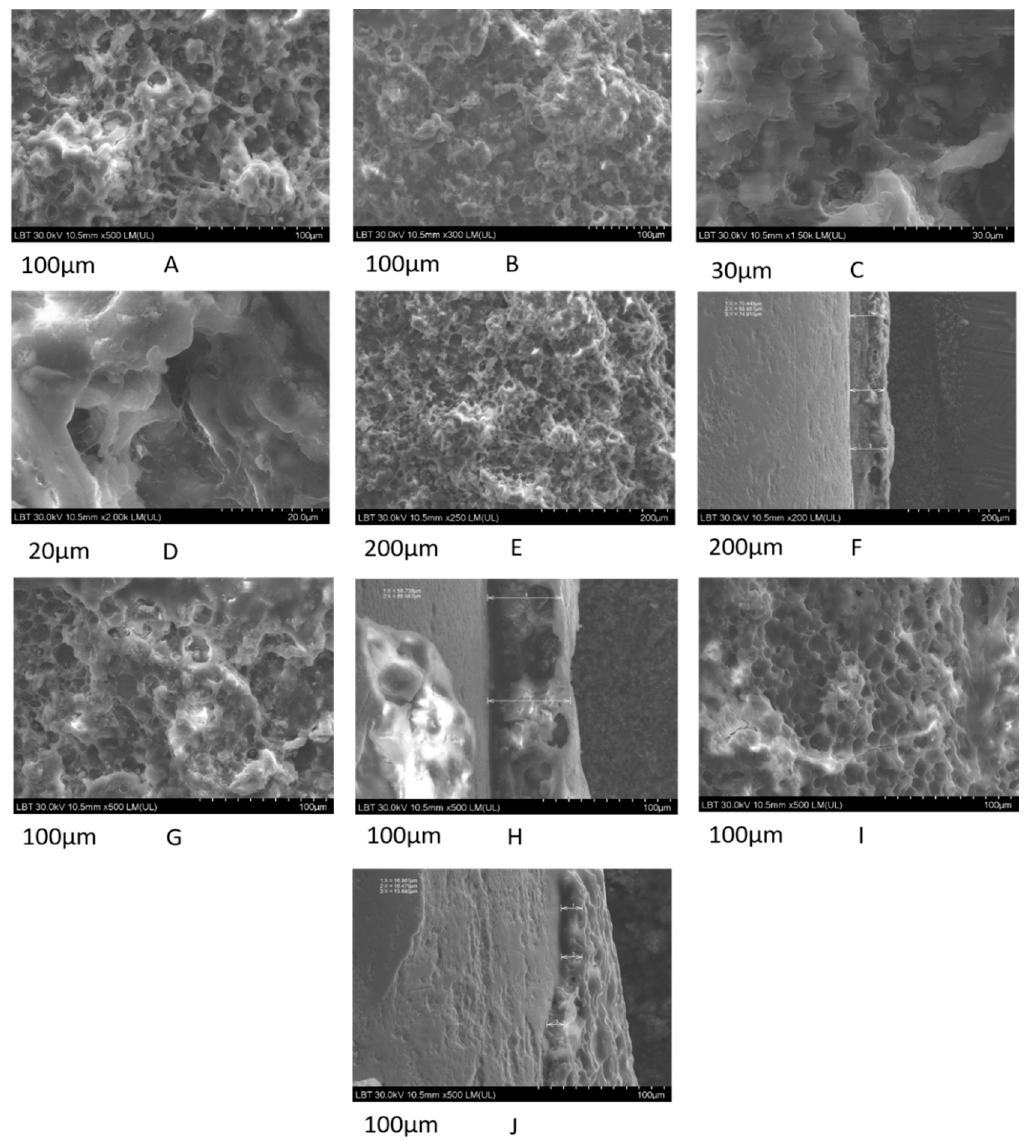
Figure 6. FE-SEM images for the bone–BCSTi implant interface without biophysical stimulation. Micro- and nanoscale structure of the retrieved implants ( A – E ) and the cross-section profile ( F ); FE-SEM image for the bone–BCSTi implant interface with HF-PESW biophysical stimulation ( G ) and the cross-section profile ( H ); FE-SEM image for the bone–STi implant interface with HF-PESW biophysical stimulation ( I ) and the cross-section profile ( J ). The scale bar sizes are 100 µm ( A , B , G – J ), 30 µm ( C ), 20 µm ( D ) and 200 µm ( E , F ).